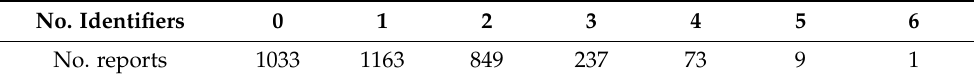
Table 4. Number of flash flood identifiers assigned per historical flood event.